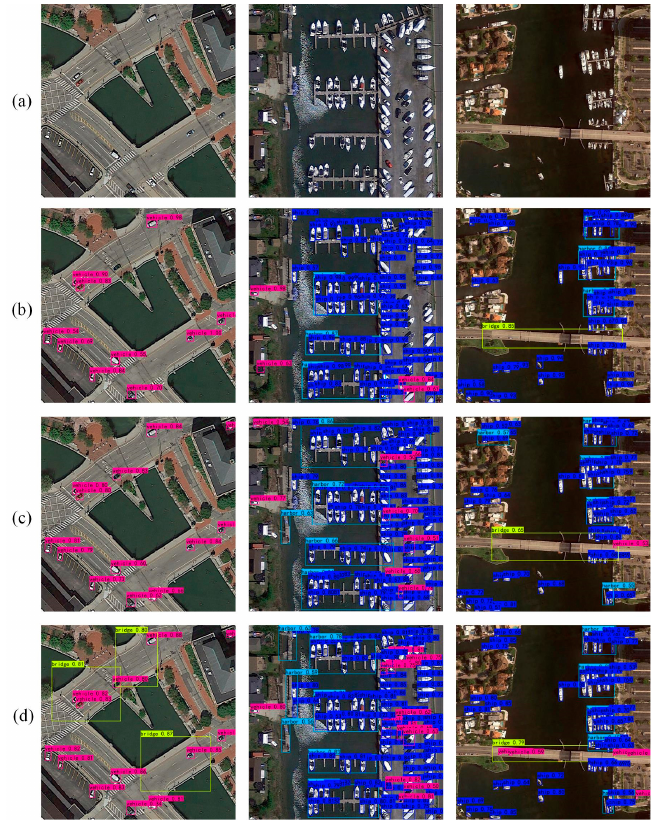
Figure 11. Detection results for the DIOR dataset: ( a ) input image; ( b ) for YOLOv4-tiny; ( c ) for YOLOX-s; ( d ) for MFANet. Table 6. AP and mAP of the different algorithms acting on multiple object categroies from DIOR data. AP stands for average precision and mAP stands for mean average precision.